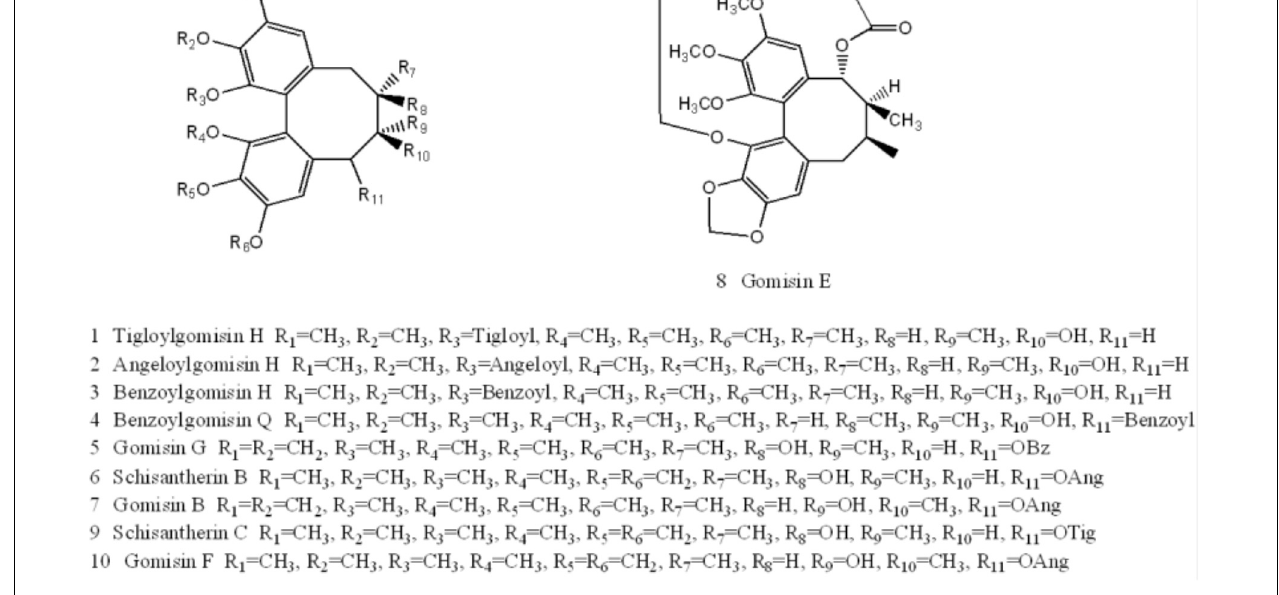
Frontiers in Pharmacology |